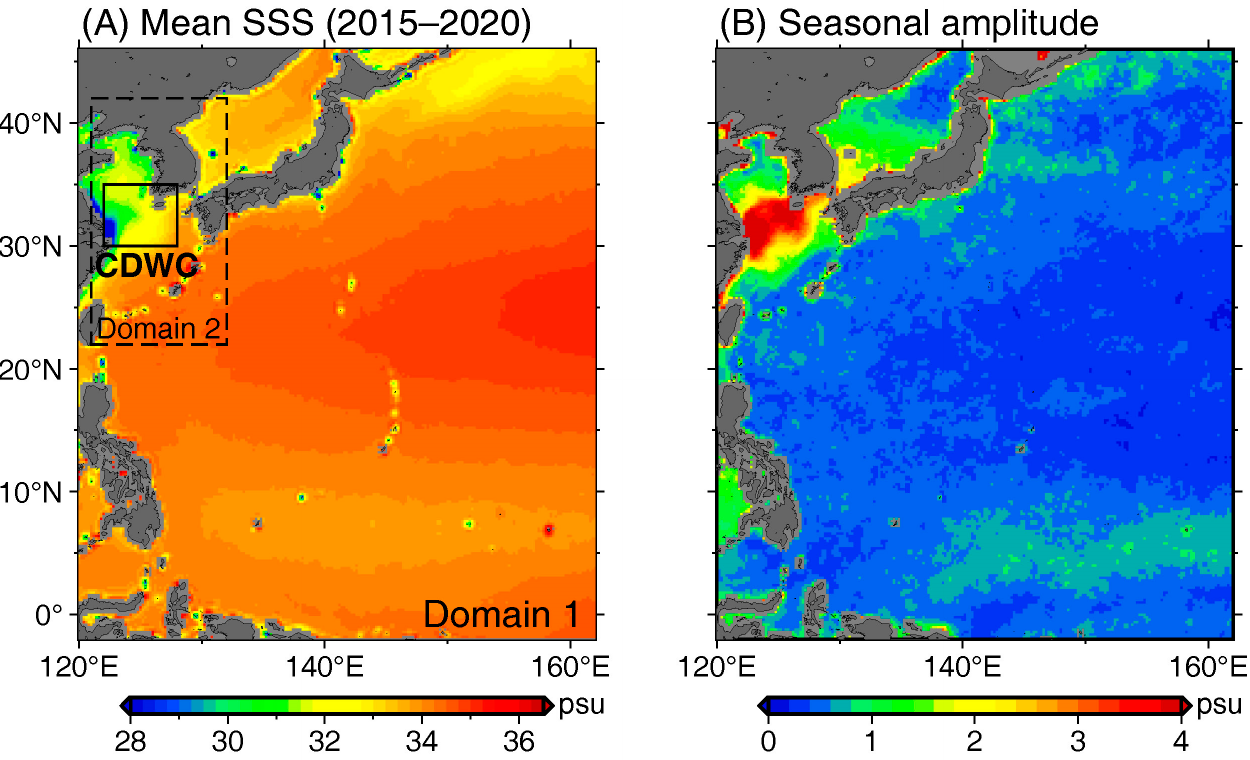
Figure 2. ( A ) Mean SSS from 2015 to 2020 and ( B ) its seasonal amplitude over Domain 1 based on satellite observations; the region of Domain 2 is marked as the dashed box. The seasonal amplitude was obtained by averaging the differences between the maximum and minimum of the SSSs in each year from 2015 to 2020. The Changjiang Diluted Water and its Continuums (CDWC; 122~128°E, 30~35°N) is also marked by the black box in panel ( A ).